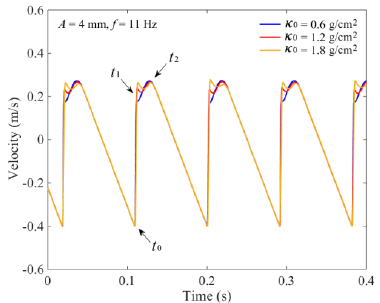
Figure 3. Variations of the vertical velocity of seeds’ mass center v Z .